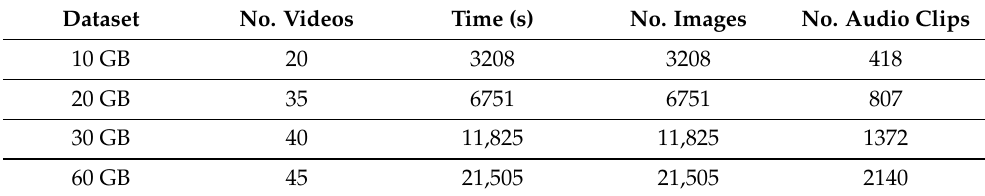
Table 2. Experimental datasets.